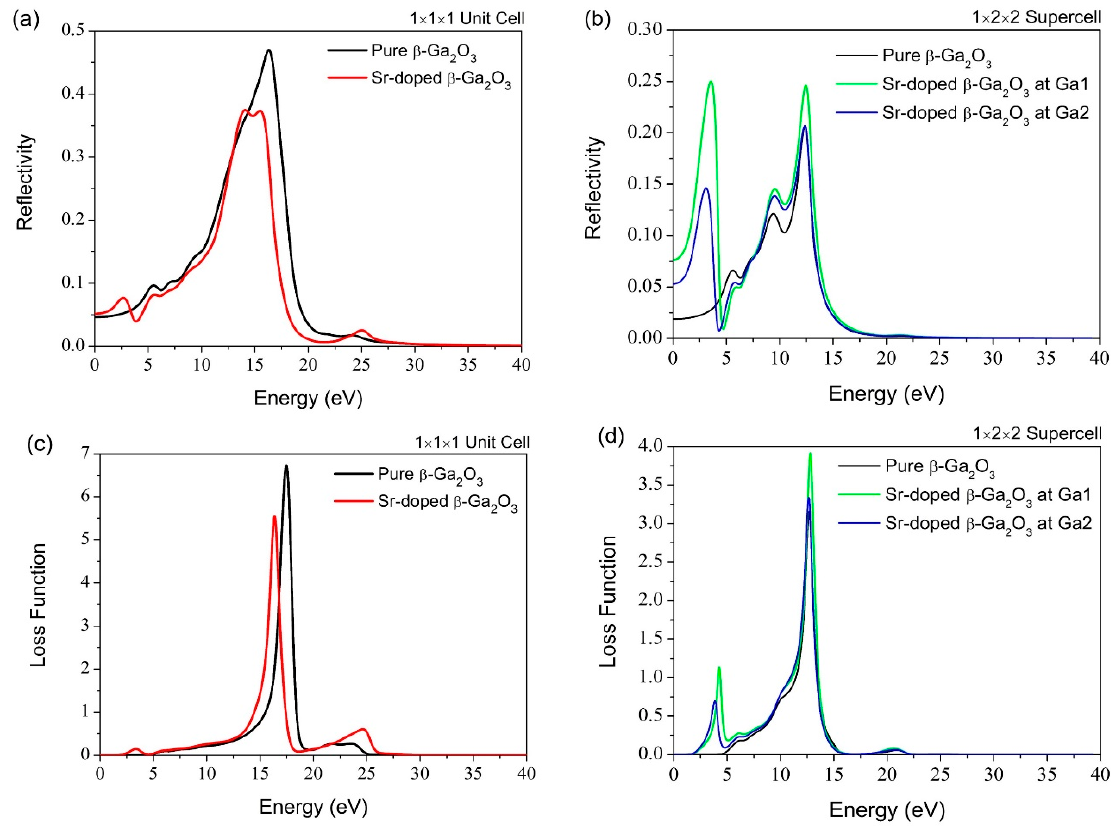
Figure 13. ( a ) Reflectivity of 1 × 1 × 1 unit cell, ( b ) Reflectivity of 1 × 2 × 2 supercell, ( c ) Loss Function of 1 × 1 × 1 unit cell, ( d ) Loss Function of 1 × 2 × 2 supercell.